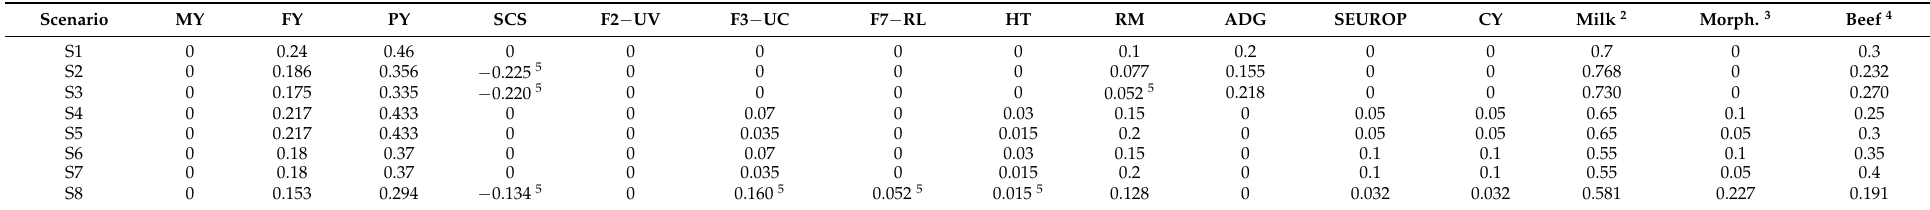
ADG, SEUROP, CY; 5 Restriction applied to target traits. Table 6. Economic weights of traits as applied after the restriction for the genetic progress of target traits 1 . The sum to 1 of the economic weights of traits considers the absolute values of the